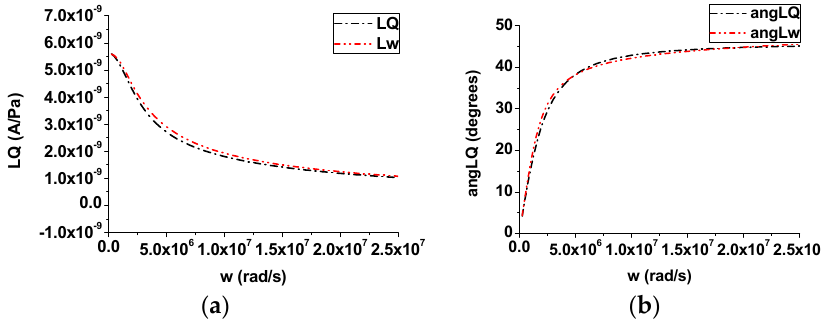
Figure 8. Variation with the frequency (time-harmonic case): ( a ) amplitude; ( b ) phase.